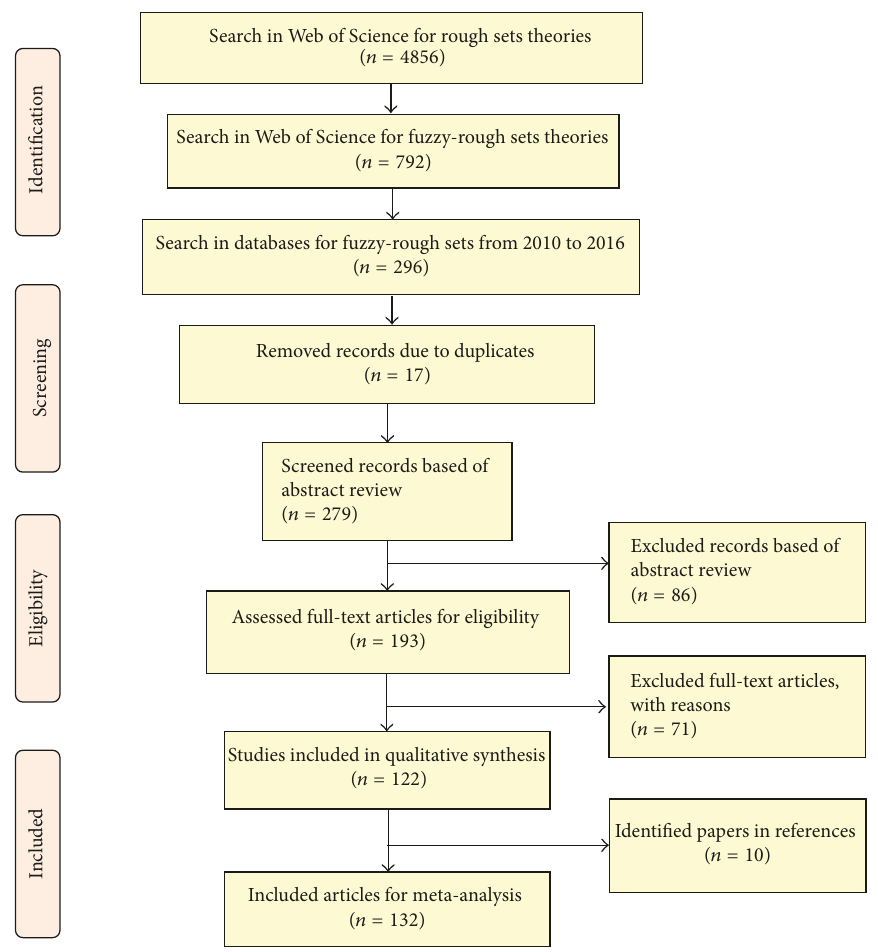
Figure 3: Study flowchart for the identification, screening, eligibility, and inclusion of articles.